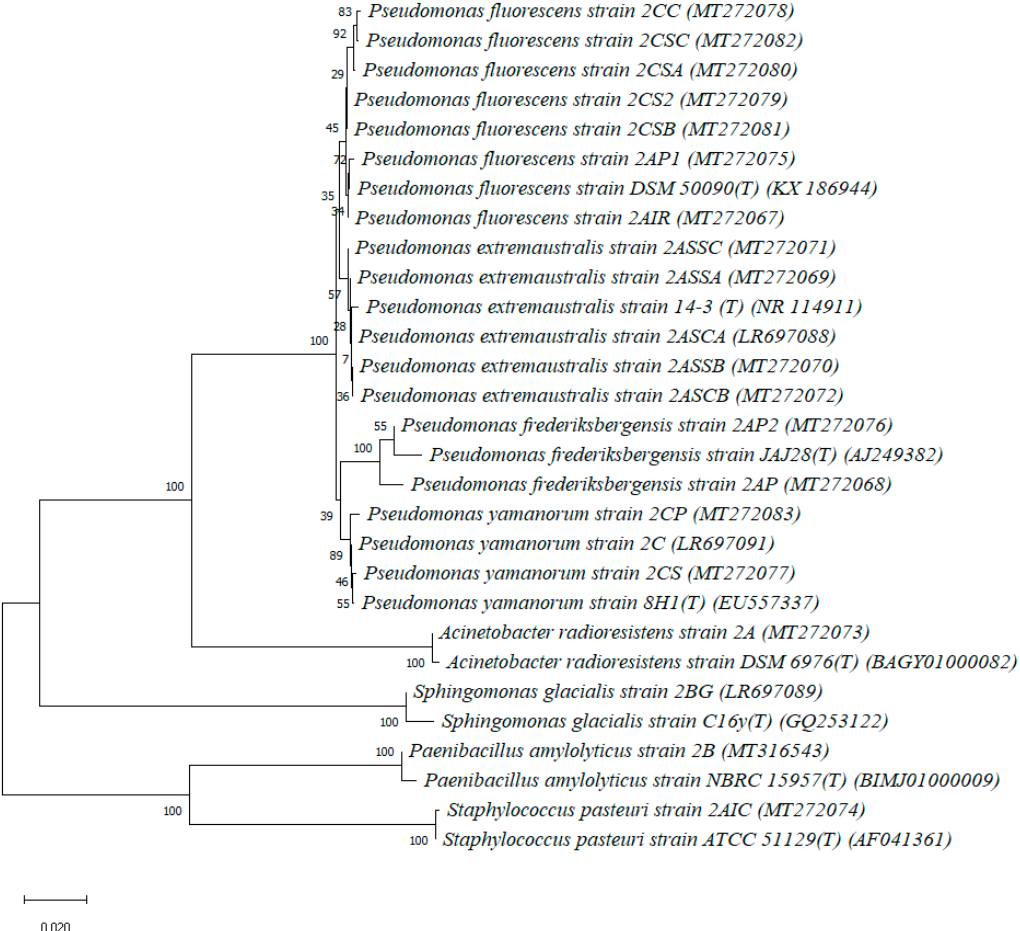
Figure 2. Neighbor-joining tree showing the phylogenetic position of bacterial strains isolated in the present study and the closest relatives based on partial 16S rRNA gene sequences, reconstructed using the Kimura 2-parameter method with 1000 bootstrap replications. The scale represents a genetic distance of 0.02 nucleotide substitutions per site.